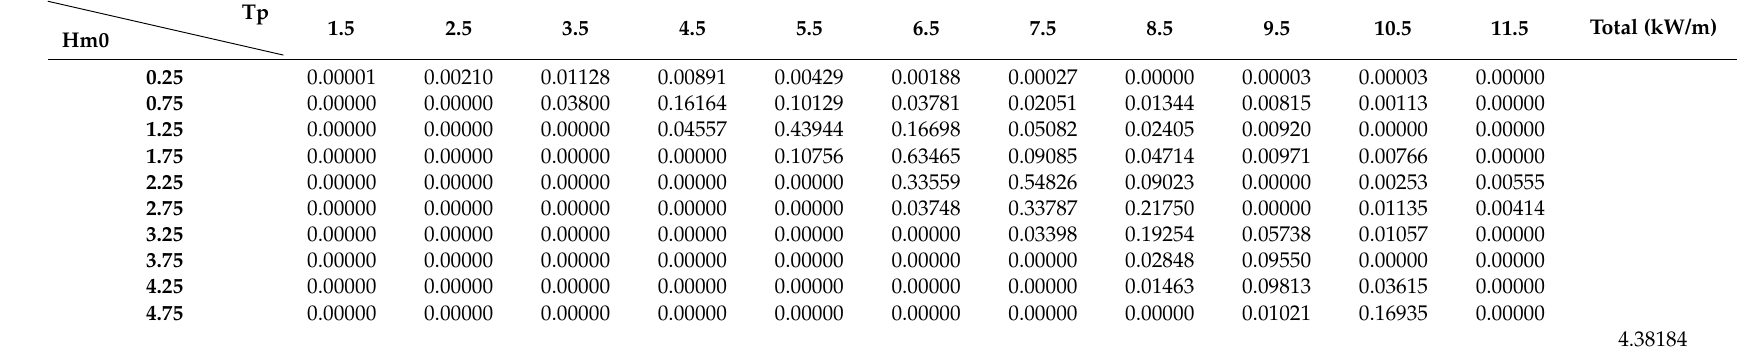
Table 3. Realistic wave power for each sea state considering the relative probability of occurrence = Pwave*Prob